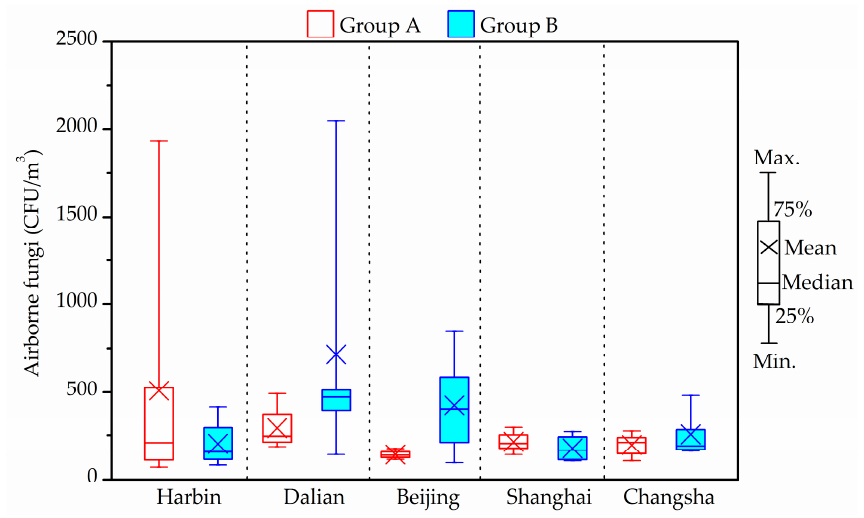
Figure 6. Indoor average level of airborne fungi in air in winter.